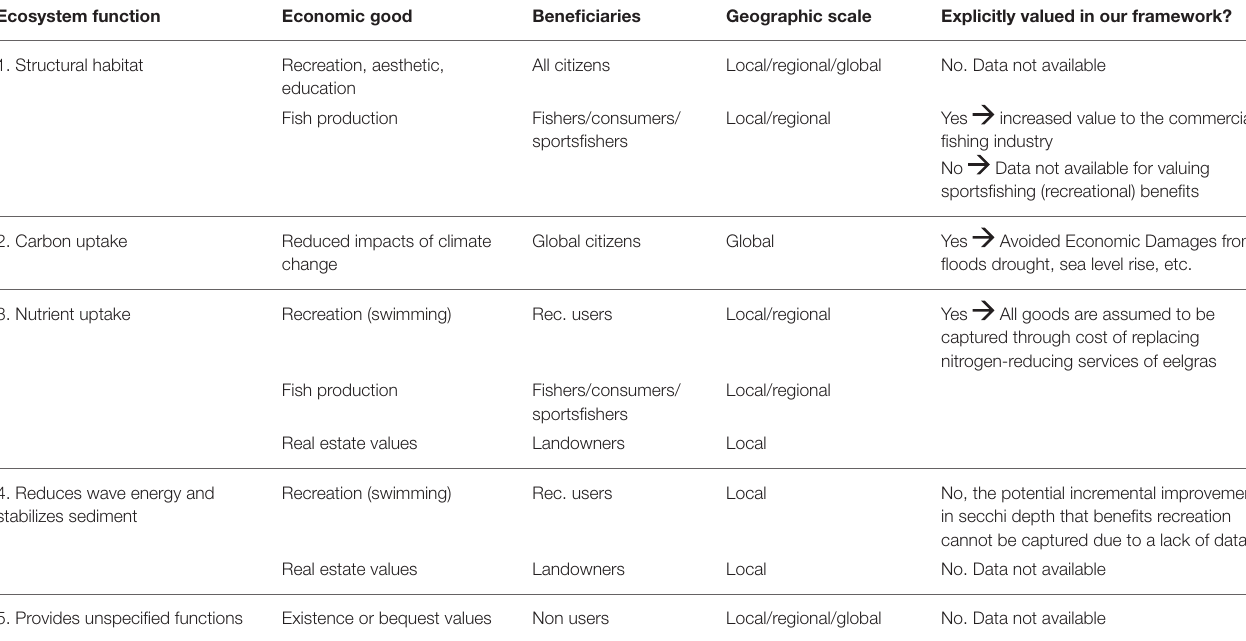
TABLE 1 | Summary of underlying ecosystem functions provided by eelgrass on Sweden’s West coast and how we value them. Ecosystem